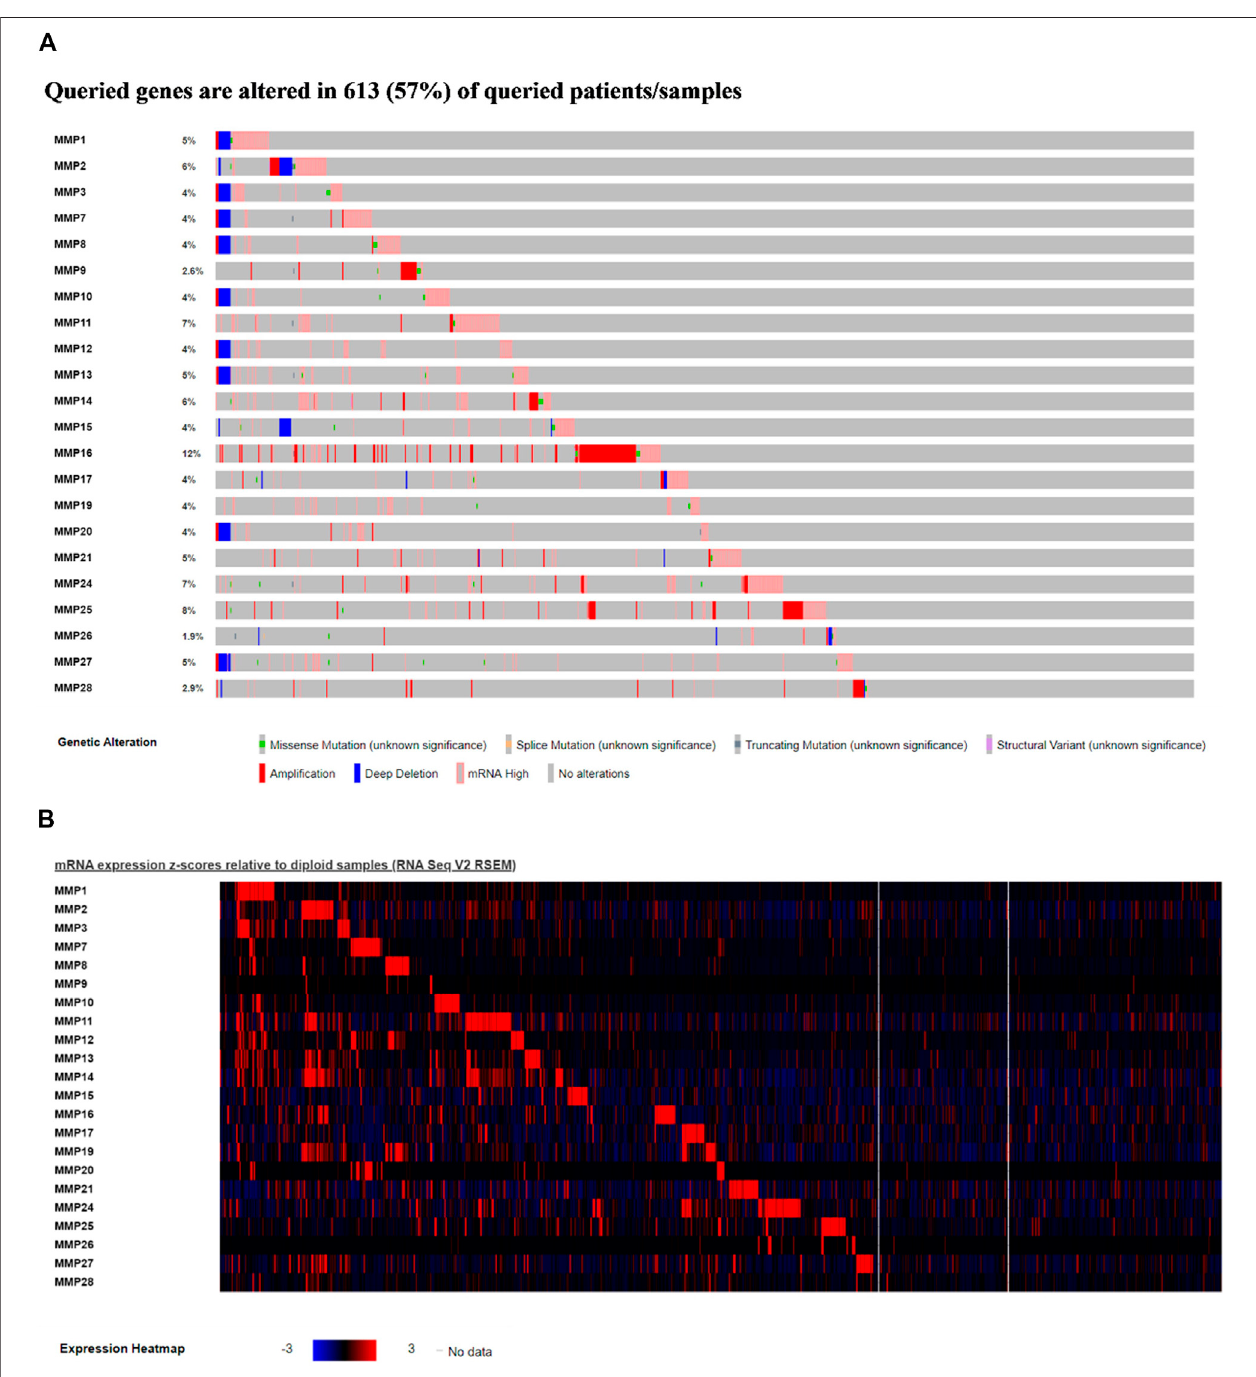
FIGURE 5 | (A) Waterfall map of alterations in different expressed MMPs in BRCA. (B) Heat map of alterations in different expressed MMPs in